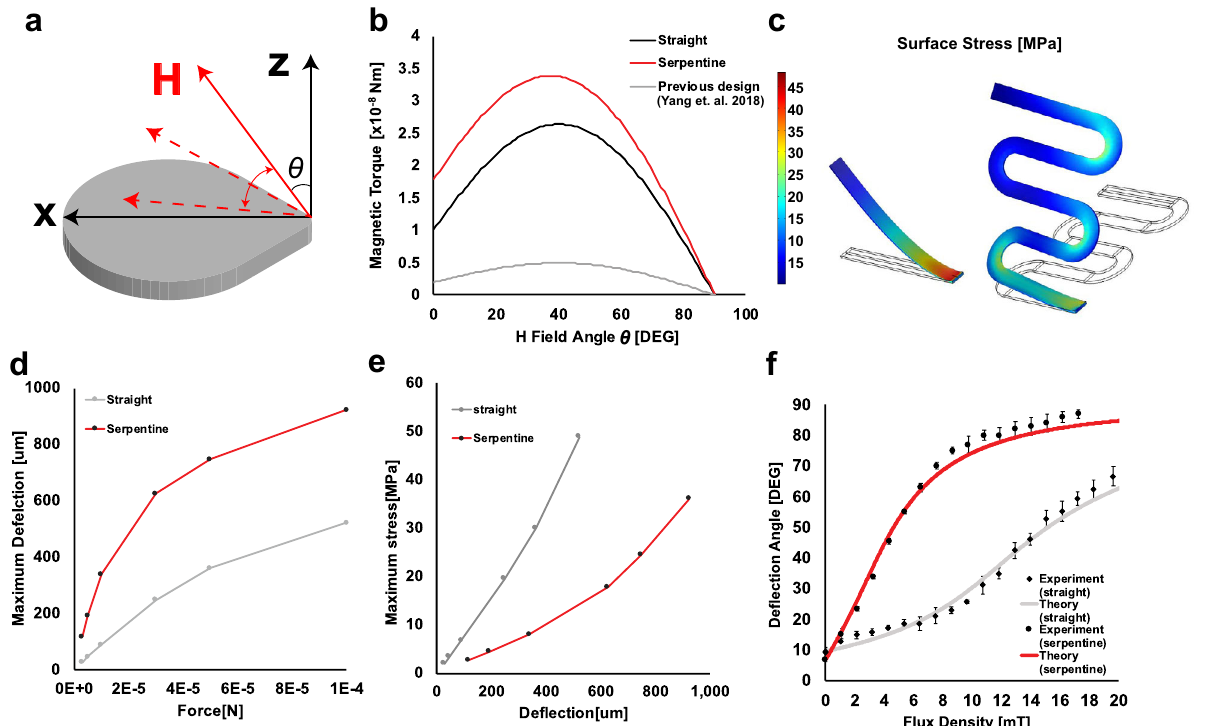
Fig. 2 Mechanical characterization. a De fi nition of the coordinate system ( x – z ) and magnetic fi eld ( H ) angle θ . b Calculated magnetic torque produced on the ferromagnetic element of serpentine (red line) and straight actuator (black line) under 15 mT at different fi eld angles. c Finite element analysis of stress distribution on cantilevers ’ surfaces under 0.1 mN load at the tip. d Maximum calculated de fl ection under loading condition (0.01 – 0.1 mN) for both cantilever types from fi nite element simulation. e Maximum calculated stress under various de fl ection conditions for both cantilever types from fi nite element simulation. f Static de fl ection angle prediction and measurements for the serpentine and the straight fl exures. Each data point represents a different experiment using an independent sample. Data are expressed as mean ± standard deviation ( n =